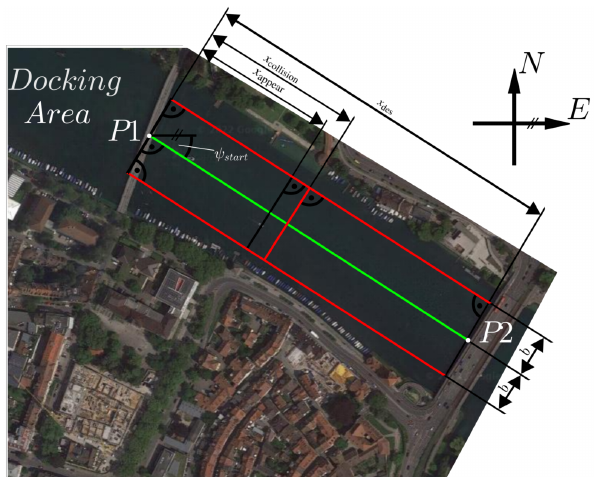
Figure 3. Bird’s eye view on the Rhine river between the docking area and the open lake [32]. The locations of P 1 and P 2 are specified in Table 3. The desired path is drawn in green. The borders to the inadmissible area next to the river bank are visualized in red. Due to the application scenario, the width and orientation of the river are approximated by 2 b = 120 m and ψ start = − 31.96 ◦